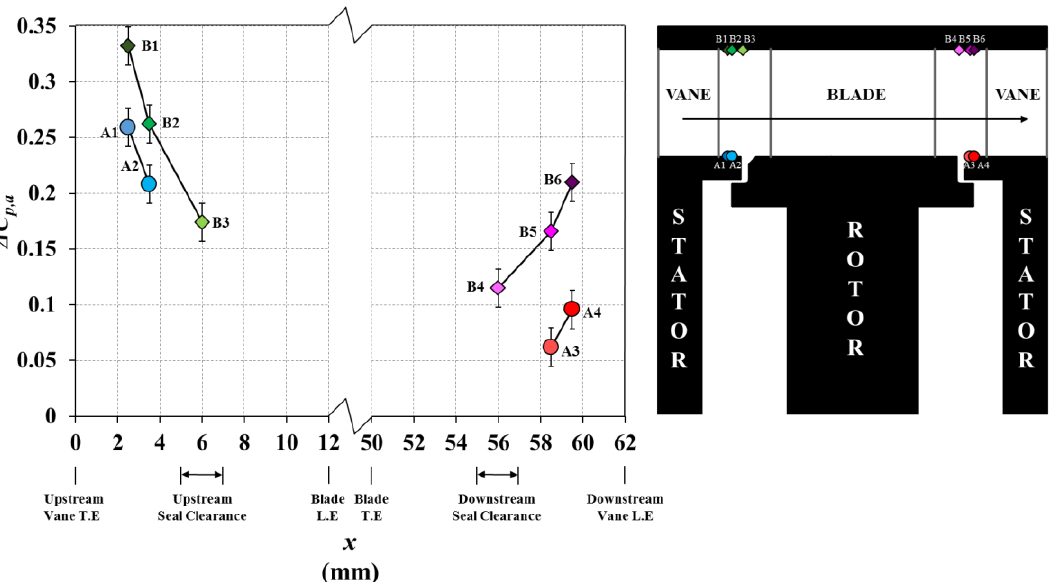
Figure 5. Variation of the circumferential pressure asymmetry in the annulus with respect to the axial positions of the upstream and downstream seal clearance and vane and blade leading edge (L.E) and trailing edge (T.E) ( C F = 0.29, Re ϕ = 7.2 × 10 5 , Φ 0 = 0).